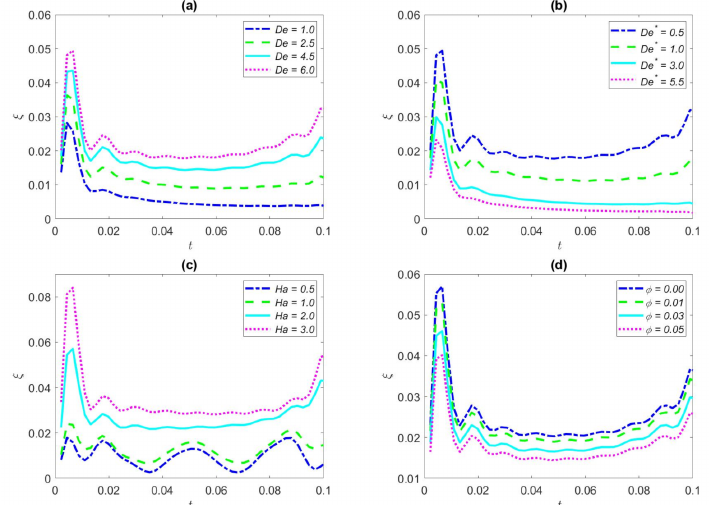
Figure 9. Distribution of the EKEC efficiency of the square waveform for some values of De , De * , Ha , ϕ . ( a ) De * = 0.5, ϕ = 2%, ω = 2, Ha = 2, K = 1; ( b ) De = 6, ϕ = 2%, ω = 2, Ha = 2, K = 1; ( c ) De = 8, De * = 0.5, ϕ = 2%, ω = 2, K = 1; ( d ) De = 6, De * = 0.5, ω = 2, Ha = 2, K =